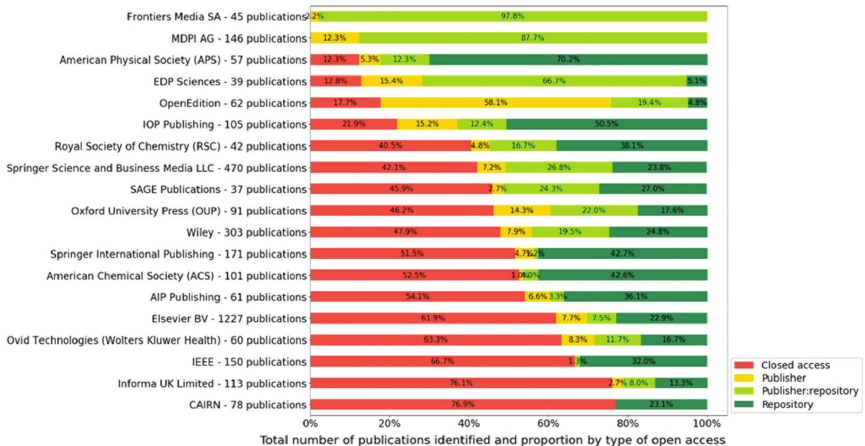
Fig. 4: Open access to publications by publisher or platform in